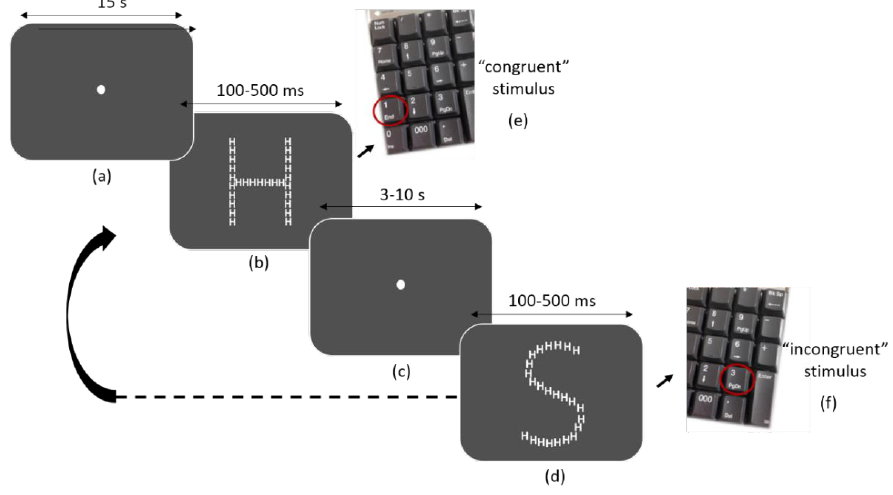
Figure 4. The four types of stimuli used in the CRTT. ( a , b ) Congruent stimuli. ( c , d ) Incongruent stimuli.